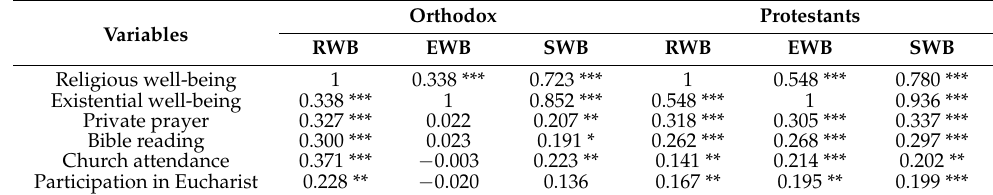
Table 5. Correlation between religious behaviour and spiritual well-being (Spearman’s rank correla-